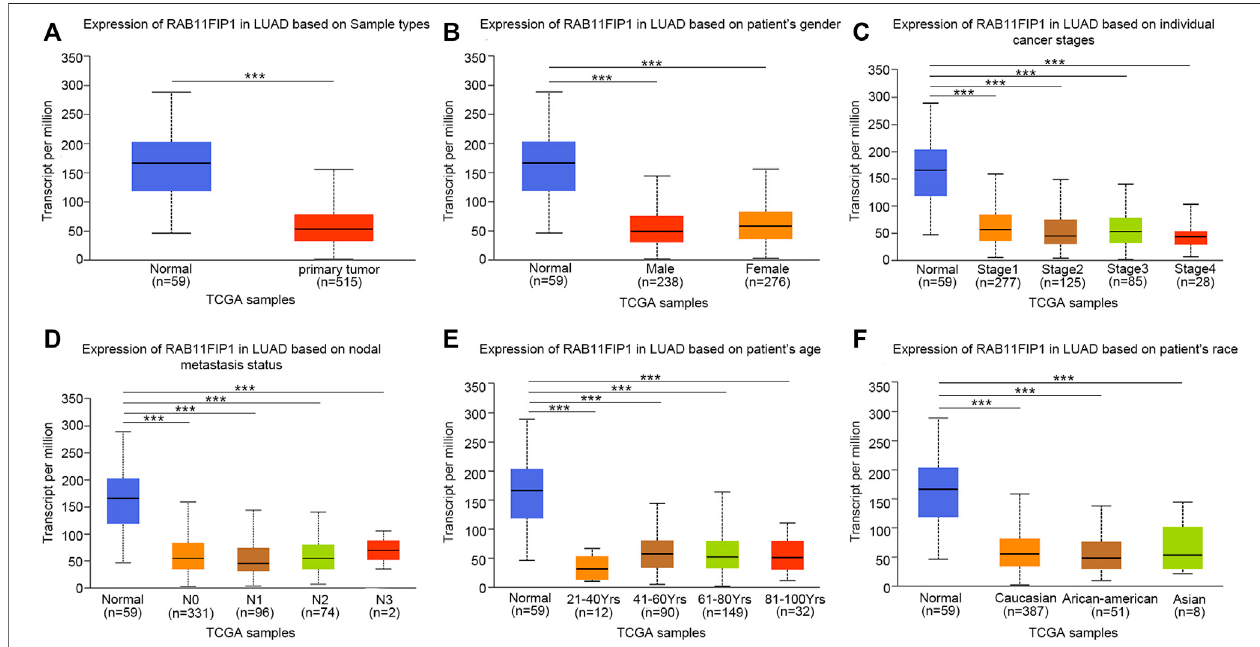
FIGURE 2 | Transcription of RAB11FIP1 strati fi ed by gender, age, and other criteria in a subgroup of patients with lung cancer. (A) Box-plot showing the relative expression of RAB11FIP1 in normal and lung cancer samples. (B) Box-plot showing the relative expression of RAB11FIP1 in normal individuals and male or female patients with lung cancer. (C) Box-plot showing the relative expression of RAB11FIP1 in normal subjects or patients with stage 1, 2, 3, or 4 lung cancers. (D) Box-plot showingtherelativeexpression ofRAB11FIP1 innormalindividualsor patients withmetastatictumors. (E) Box-plot showingtherelative expression ofRAB11FIP1